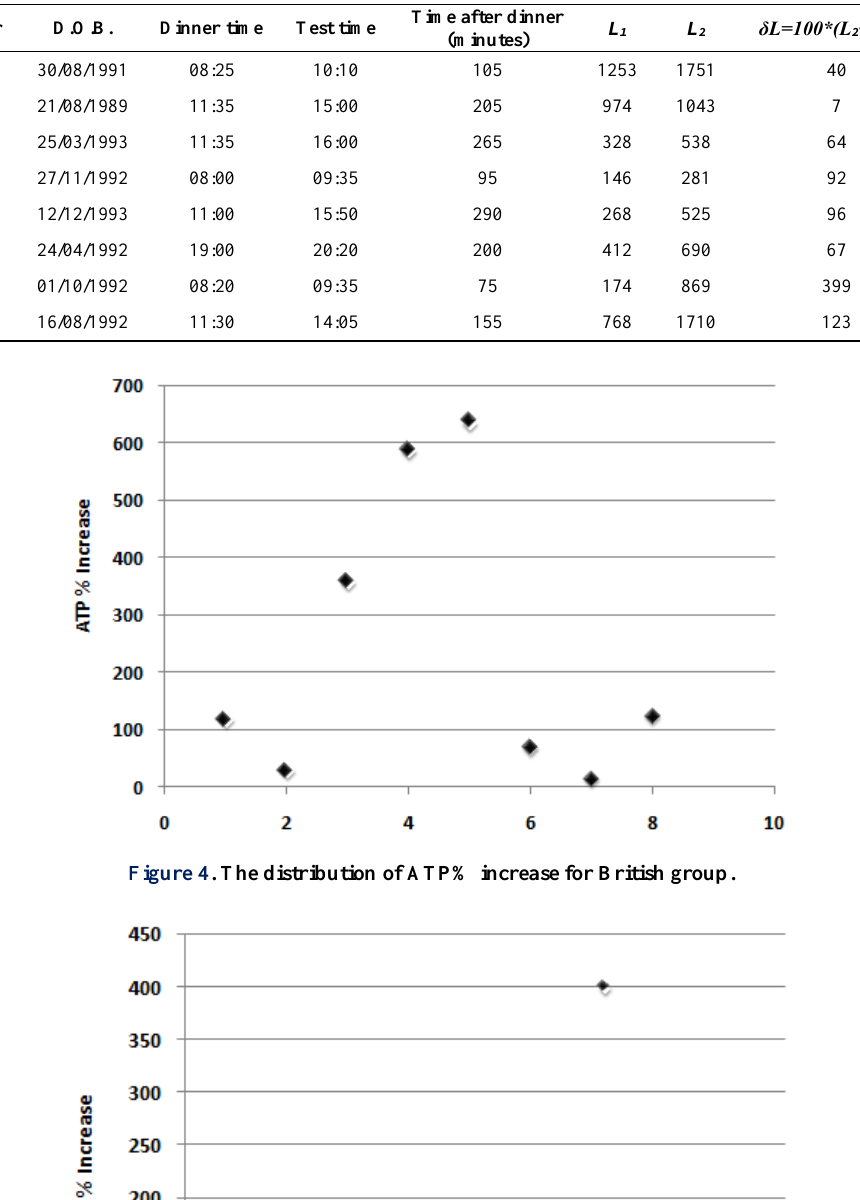
Table 5. The Test results of ATP test for the ten people from China.